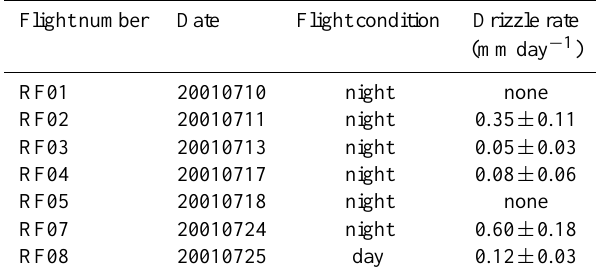
Table 3. List of C-130 flights for DYCOMS-II used in this study. Drizzle rates are from van Zanten et al.